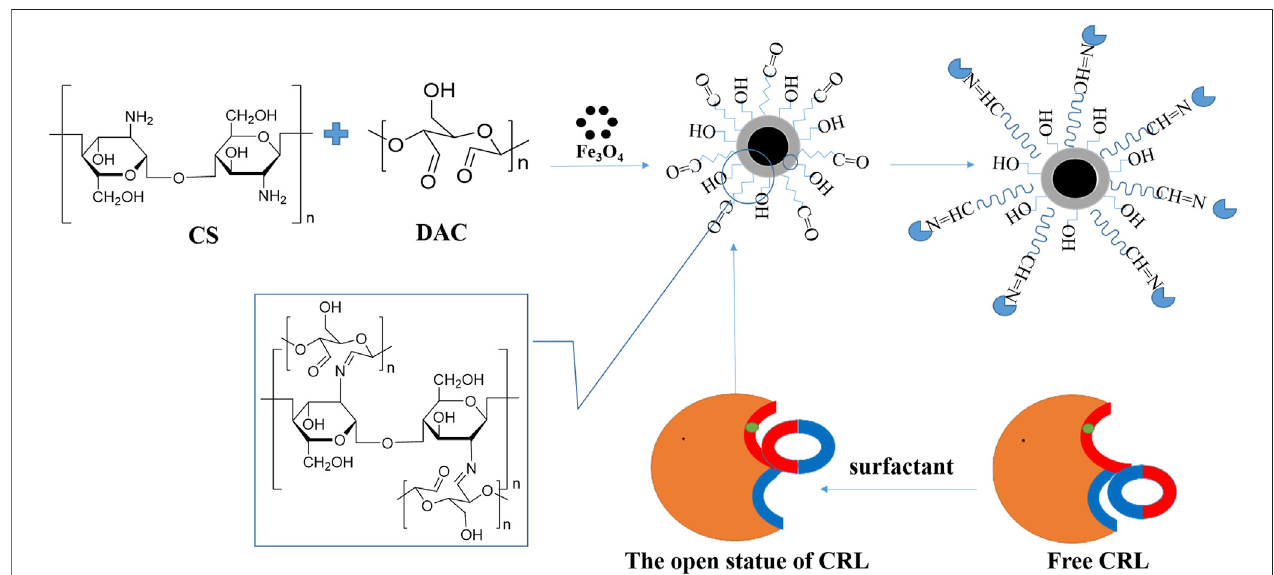
FIGURE 1 | Schematic diagram of preparation of immobilized support and immobilized Candida rugosa lipase (CRL).